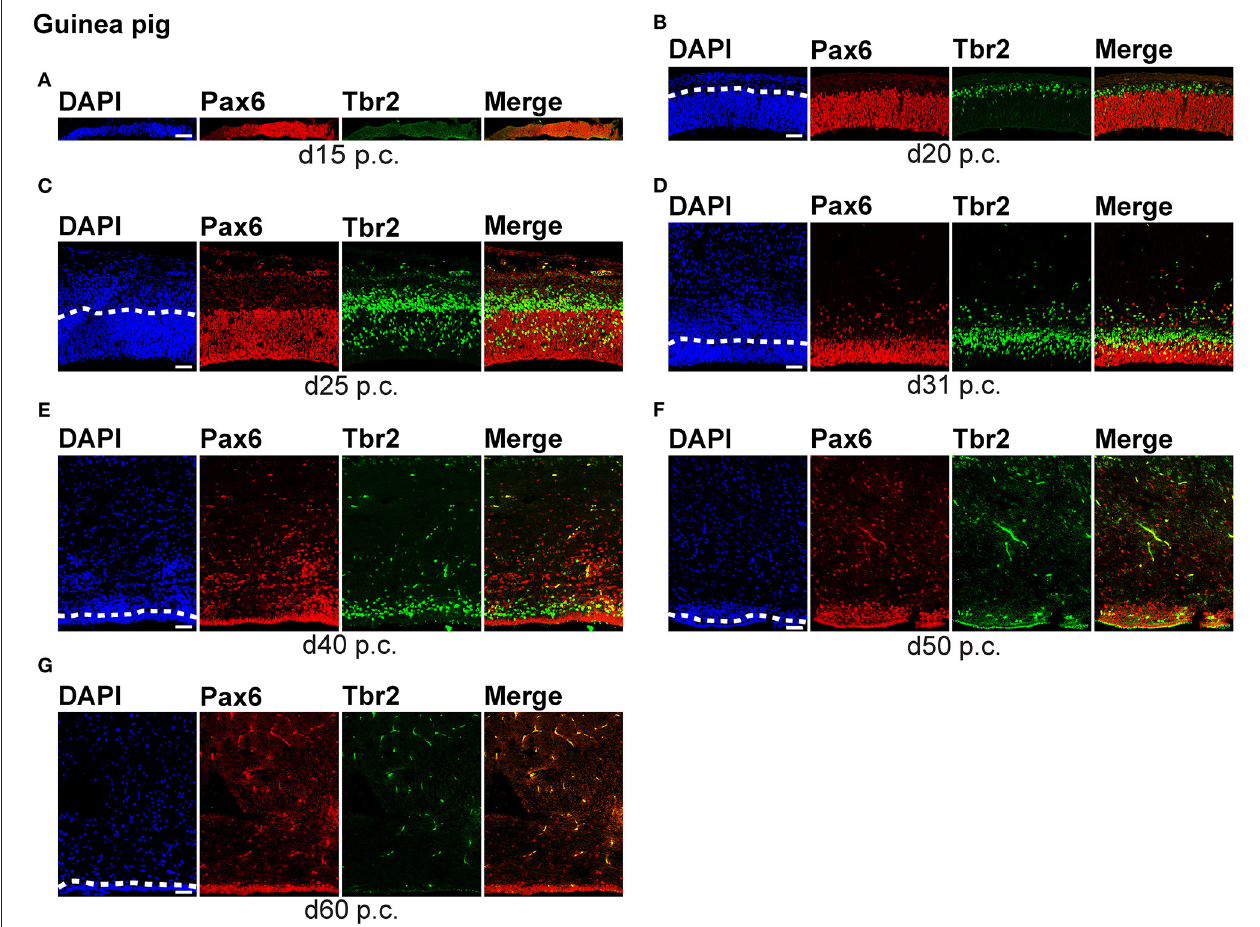
FIGURE 2 | Pax6 and Tbr2 expression in the germinal zones of the developing guinea pig neocortex. (A–G) Double immunofluorescence for Pax6 (red) and Tbr2 (green) and DAPI staining (blue) on 30- µ m cryosections of day 15 to 60 post-conception (p.c.) guinea pig neocortex. The merge images show combined immunofluorescence for Pax6 and Tbr2. (A–C) The complete cortical wall is shown. (D–G) The top margin of the image corresponds to the transition zone SVZ/intermediate zone (D) or the intermediate zone (E–G) . Scale bars, 50 µ m. The dashed line indicates the border between VZ and SVZ. VZ, ventricular zone; SVZ, subventricular